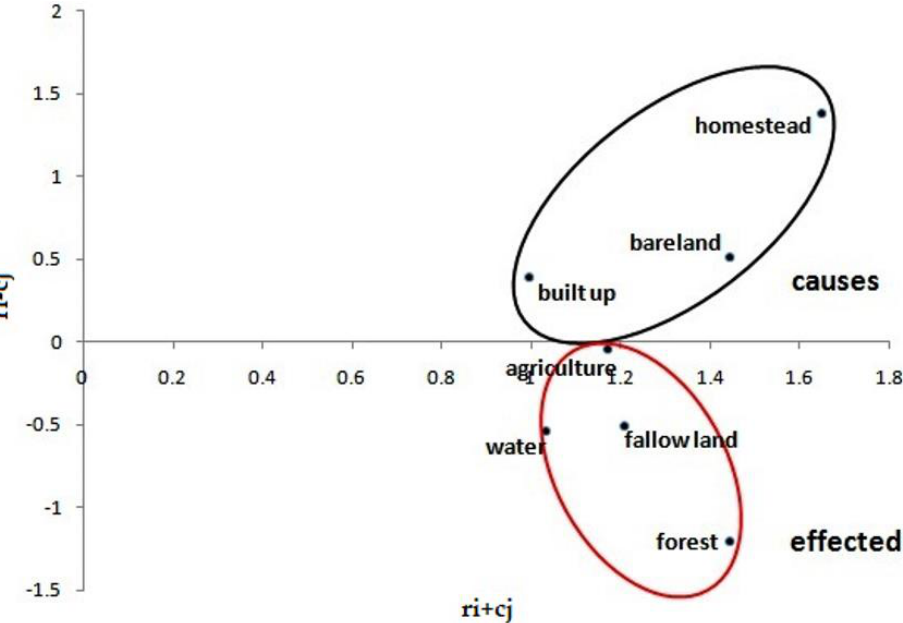
Figure 5. Causal diagram associated with the effects and caused connected to the land use/cover classes analyzed in the present study.